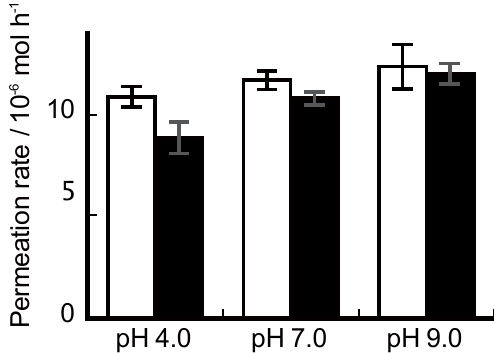
Figure 6. Efects of pH on the permeability of NaCl across (PAH-PSS) (PAH-PSS) PAH films (filled column) with a 3 mm diameter. The average values of three 5 measurements are reported.